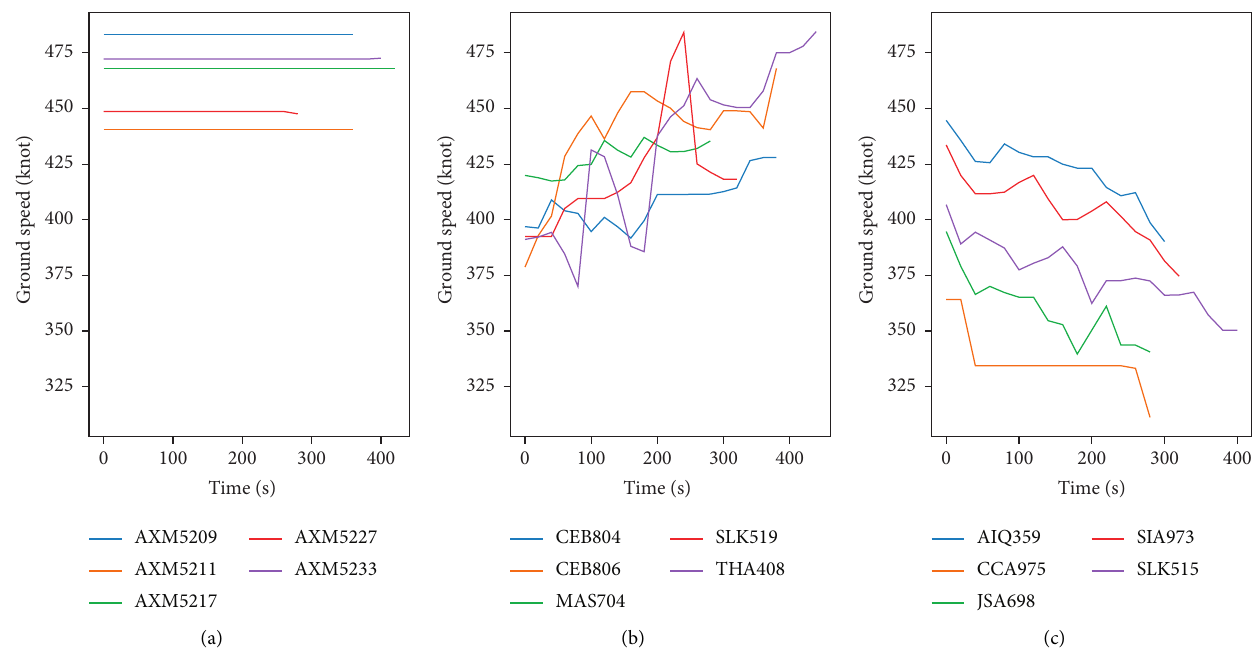
Figure 9: Example of trends in ground speed from real data. Three figures share the same y -axes which is the ground speed in knot. (a) Maintaining speed, (b) increasing speed, and (c) decreasing